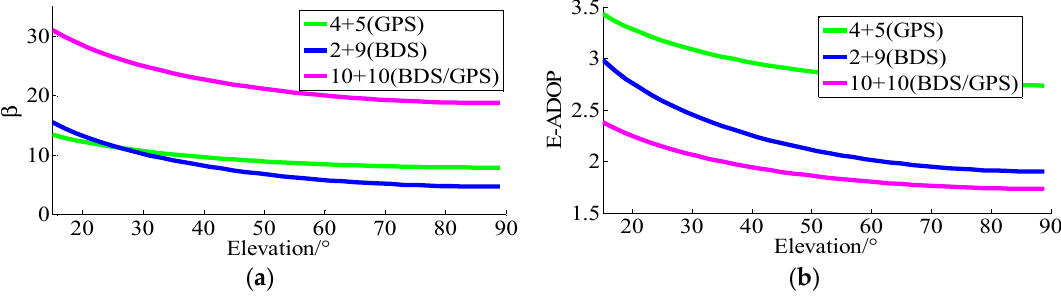
Figure 5. The β and E-ADOP of GPS, BDS and BDS/GPS. ( a ) The β of GPS, BDS and BDS/GPS. ( b ) The E-ADOP of GPS, BDS and BDS/GPS.